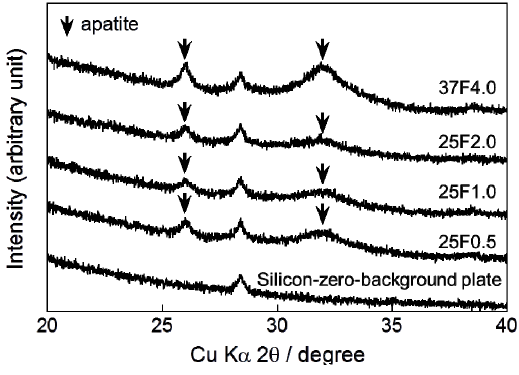
Figure 3. XRD (X-ray diffraction) patterns from a silicon-zero-background plate and CaP (calcium phosphate) deposited on the 25F0.5, 25F1.0, 25F2.0, and 37F4.0 groups. Arrows indicate the diffraction peaks corresponding to those for